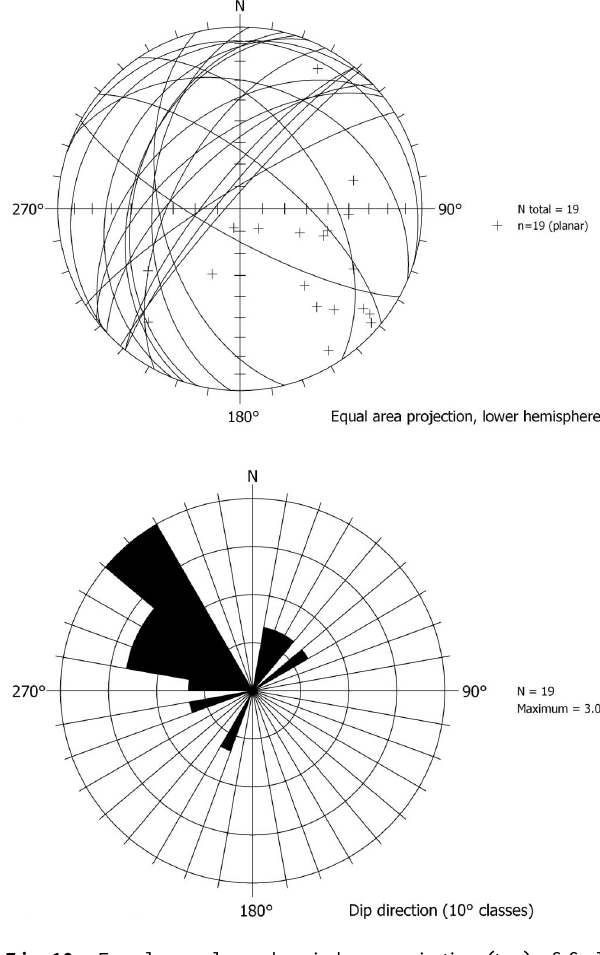
Fig. 10. Equal-area, lower hemisphere projection (top) of fault plane projections of intermediate depth events and rose-diagram of dip directions (bottom). Fault planes are shown as great circles and dip predominantly to the NW. Data is shown in Table